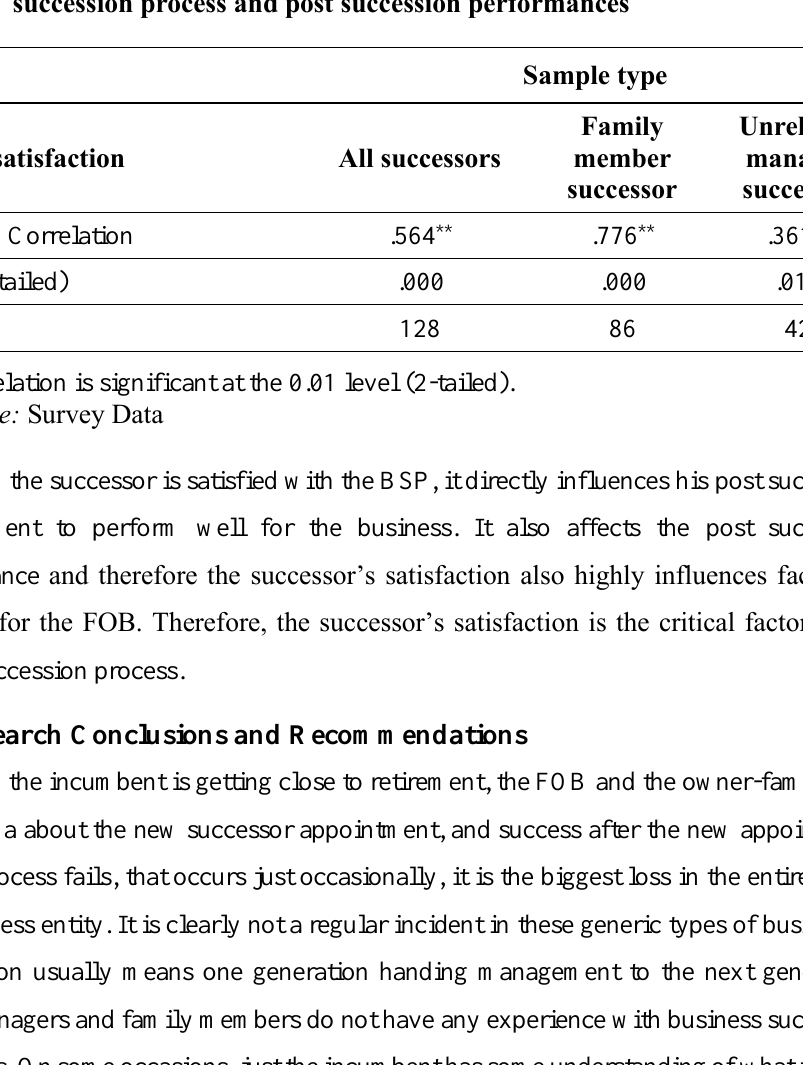
Table 5: Relationship between successor’s initial satisfaction with the business succession process and post succession